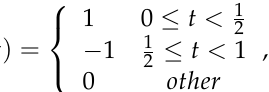
Figure 1. Three level decomposition of 1-D signal.